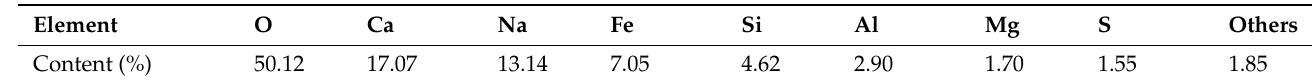
Table 2. XRF analysis of